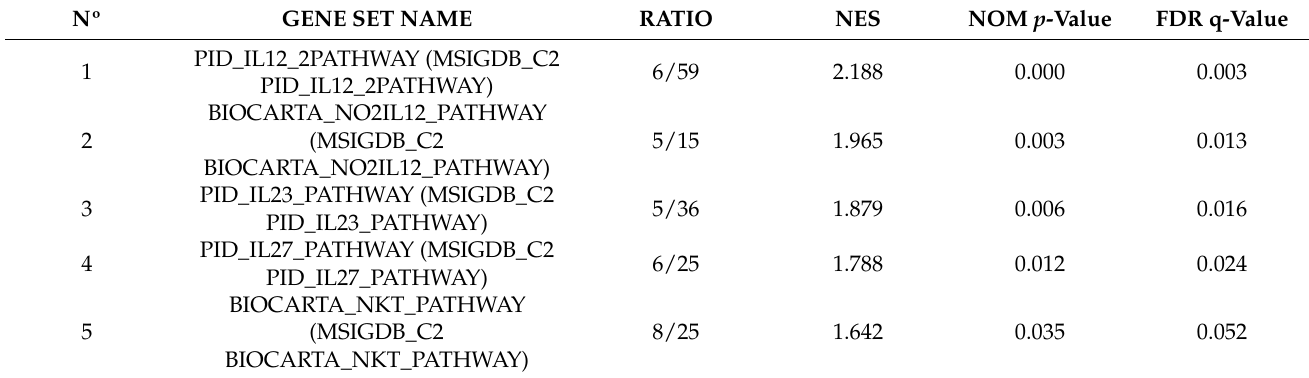
Table 3. Gene sets upregulated in 10 days post